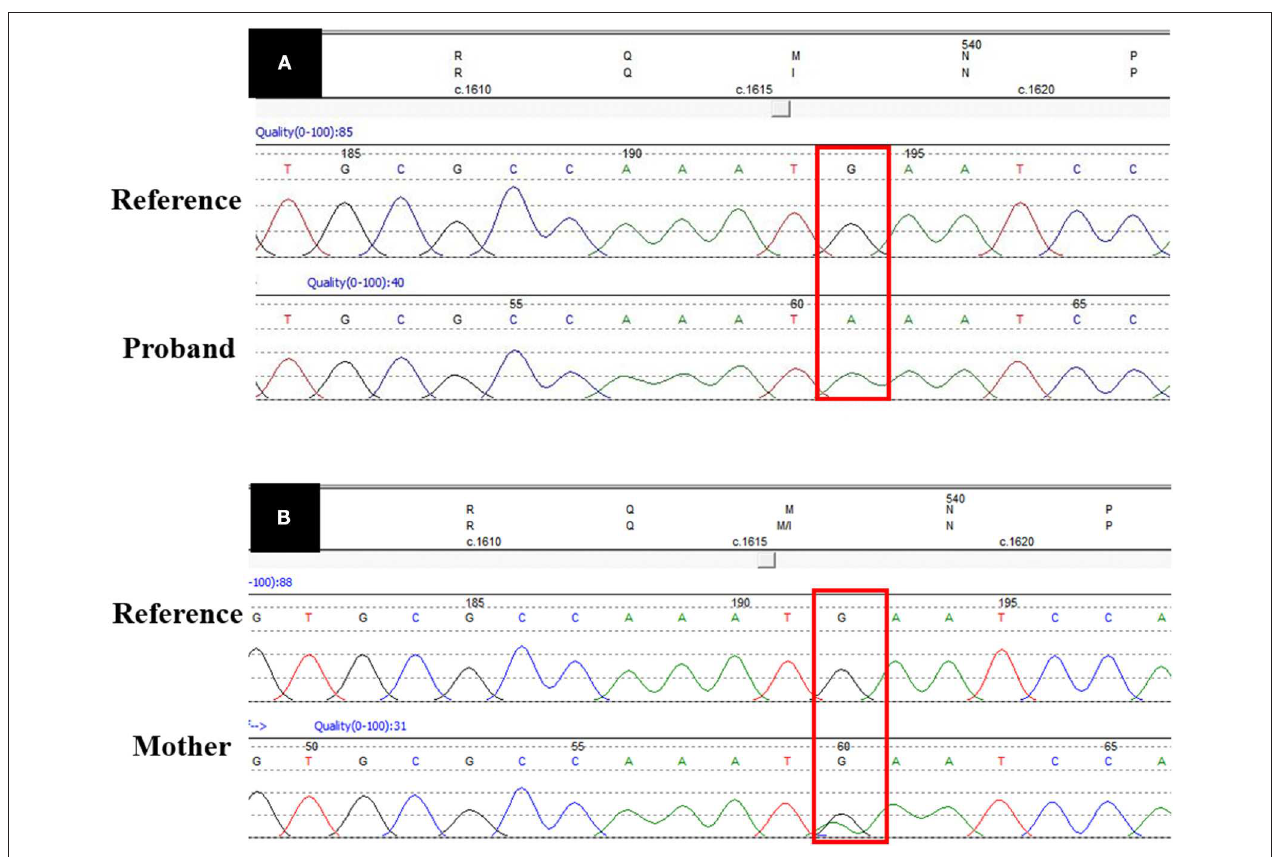
FIGURE 3 | UBA1 sequence data. (A) Shows the pathogenic missense variant (c.1617G > A) in proband’s DNA sequence as compared with the reference DNA sequence. (B) Shows the heterozygous DNA sequence in the carrier mother. The red box shows the variant